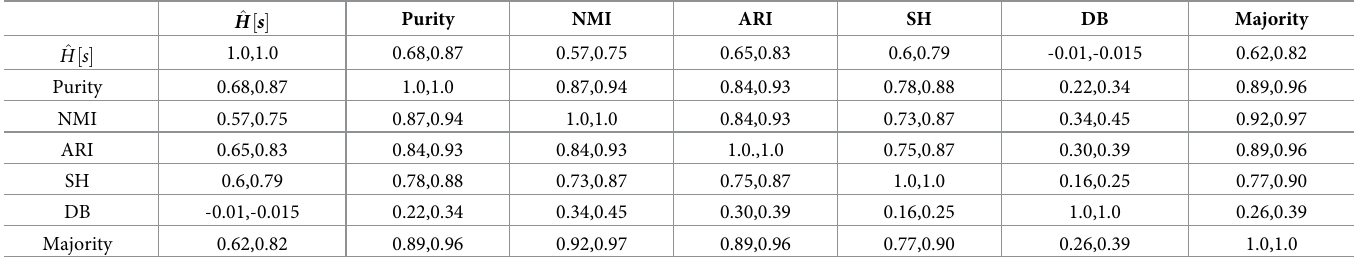
Table 11. Kendall’s τ and Spearman’s correlation result for Football.